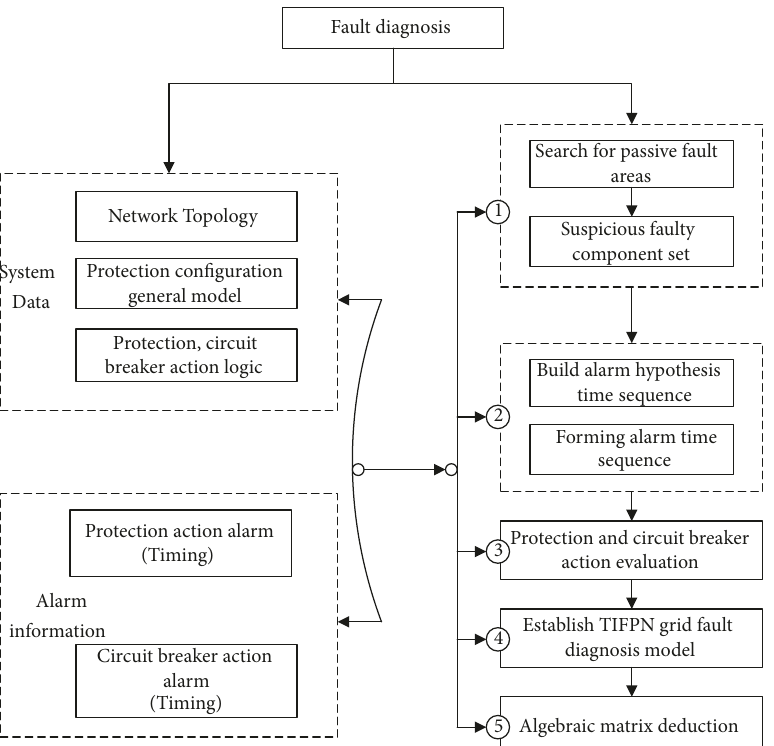
Figure 3: Fault diagnosis model frame structure.